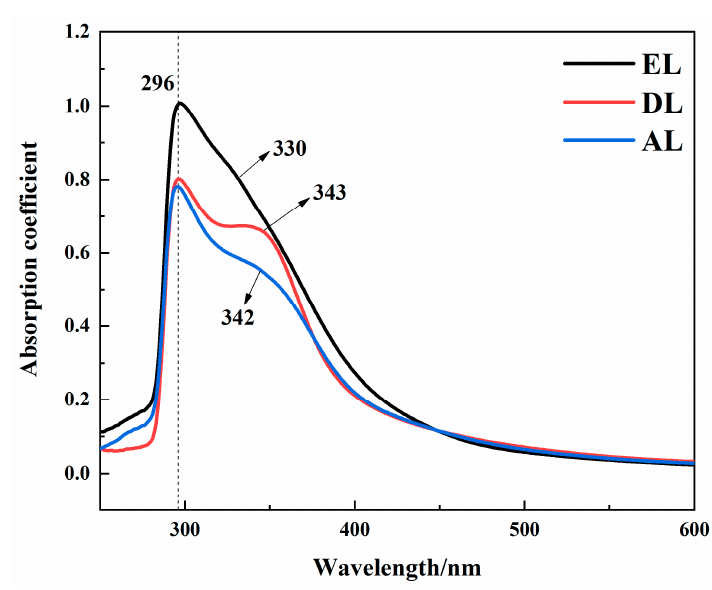
Figure 2. UV ‒ Vis spectra of different kinds of lignin. Figure 2. UV − Vis spectra of different kinds of